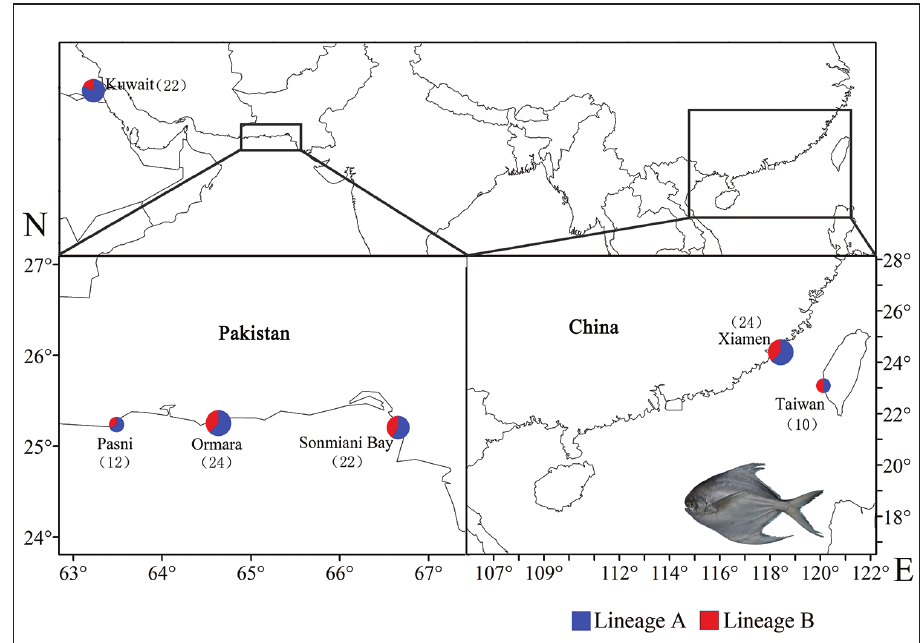
Figure 1. Sampling locations of P. argenteus